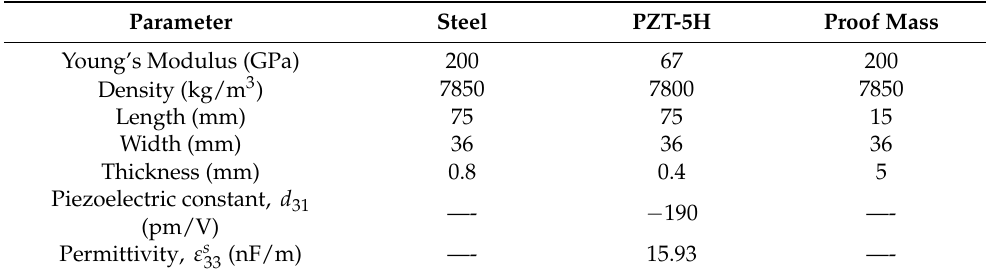
Table 1. The geometrical and mechanical characteristics of the substrate layer, piezoelectric patch, and proof